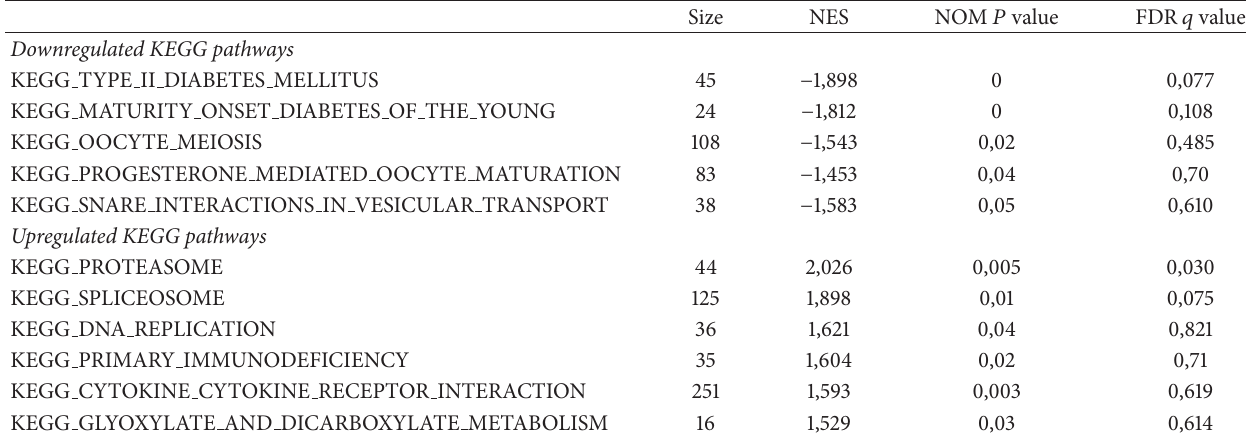
Table 2: List of down- and upregulated pathways in hyperglycemic donors.